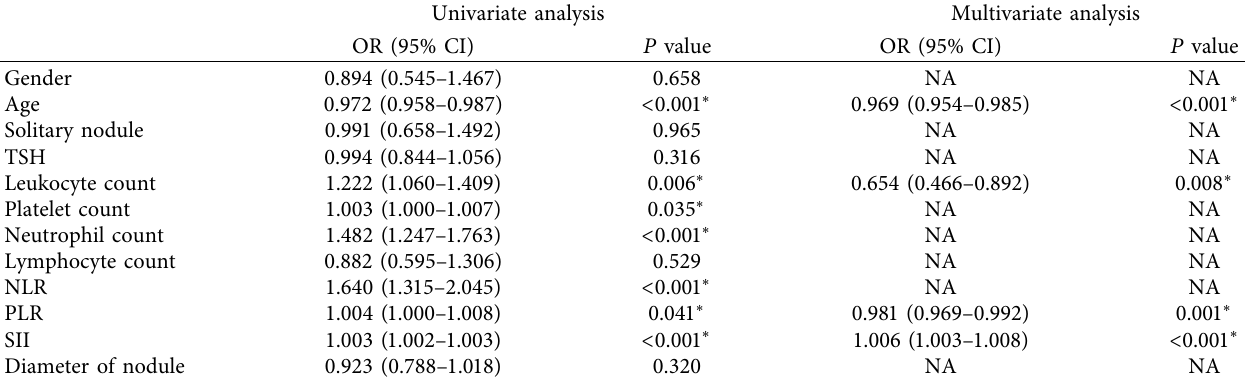
Table 2: Univariate and multivariate logistic regression models in malignant influencing factors of thyroid